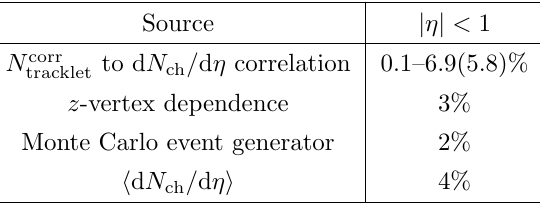
Table 1 . Sources of systematic uncertainties on the normalized charged-particle multiplicity. For the N corr to d N ch = d (cid:17) correlation an interval is quoted, varying with multiplicity, with a di(cid:11)erent tracklet maximum uncertainty for the Pb(p)-going